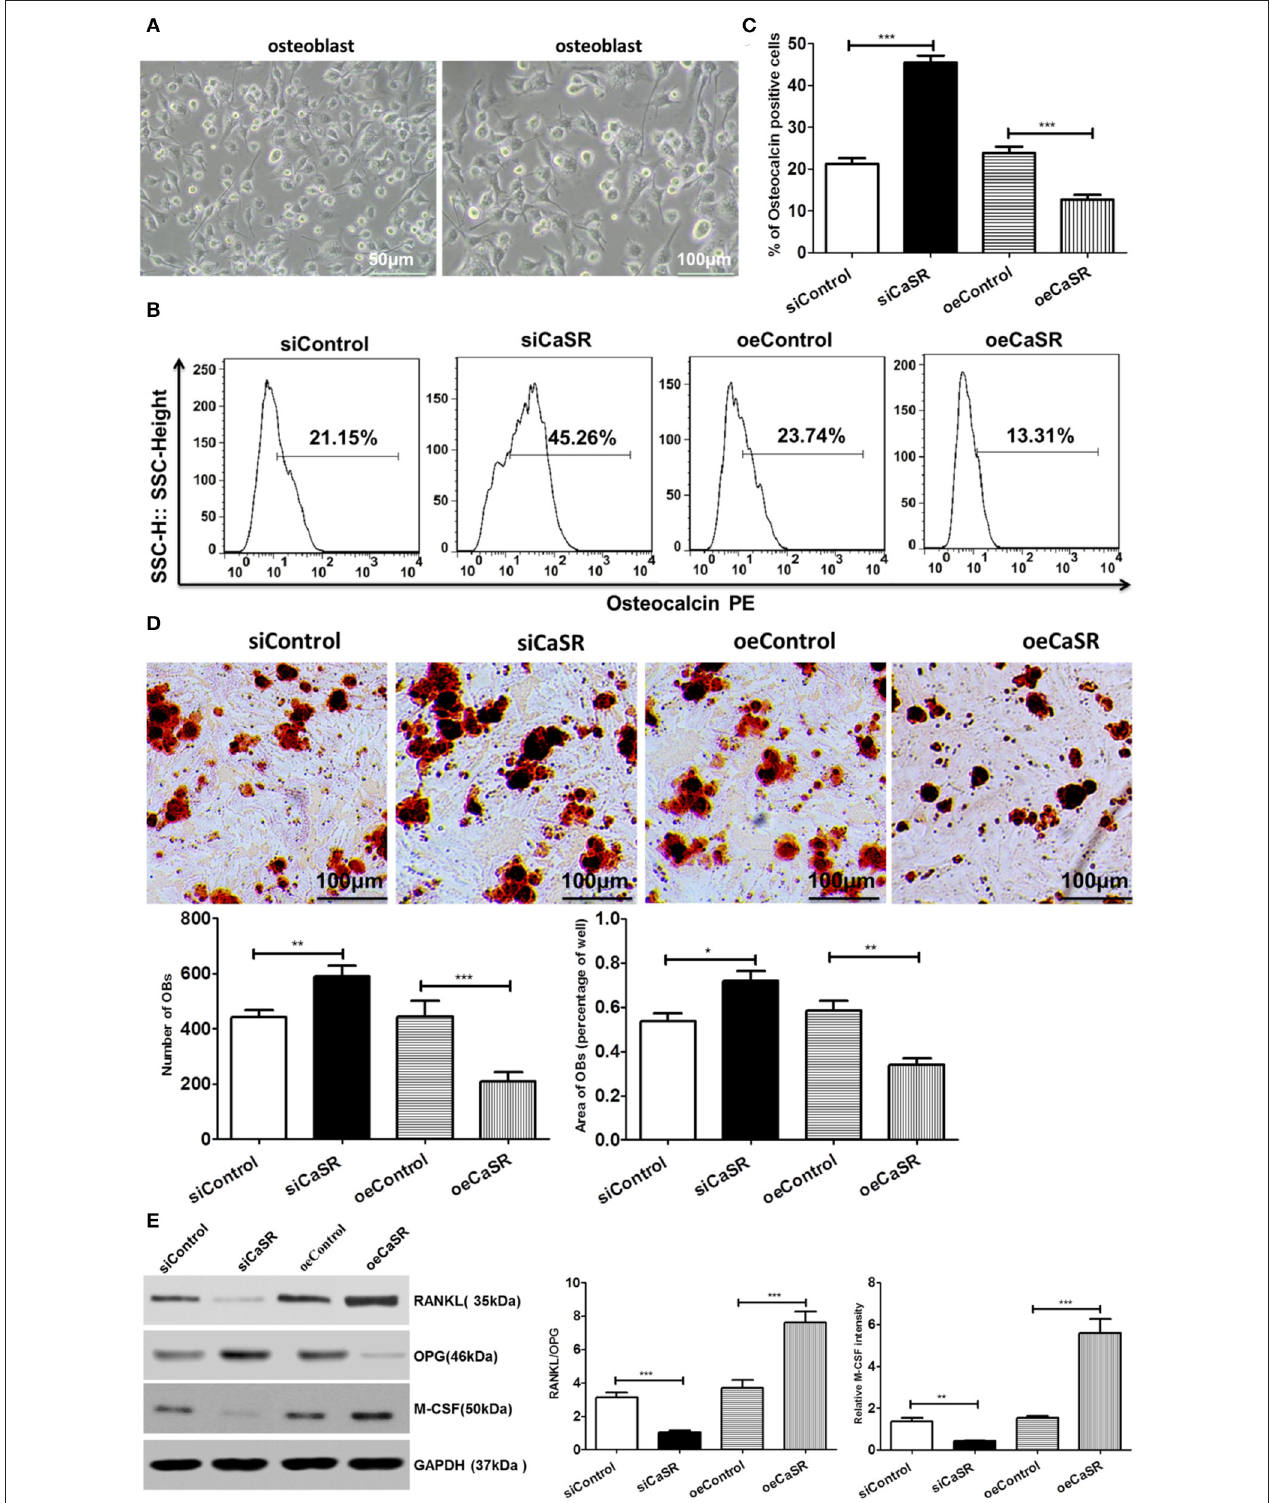
FIGURE 5 | Analysis of CaSR effects on OBs. (A) Primary culture and identification of rat OBs. (B–D) Four groups of OB precursor cells were treated with CM from co-cultured modified A549 cells with macrophages to examine potential OB differentiation induction. Flow cytometry was used to detect expression of osteocalcin-positive OBs. OB mineralization nodule staining was performed with Alizarin Red S (AS). AS + cells were counted using 400-fold microscope and